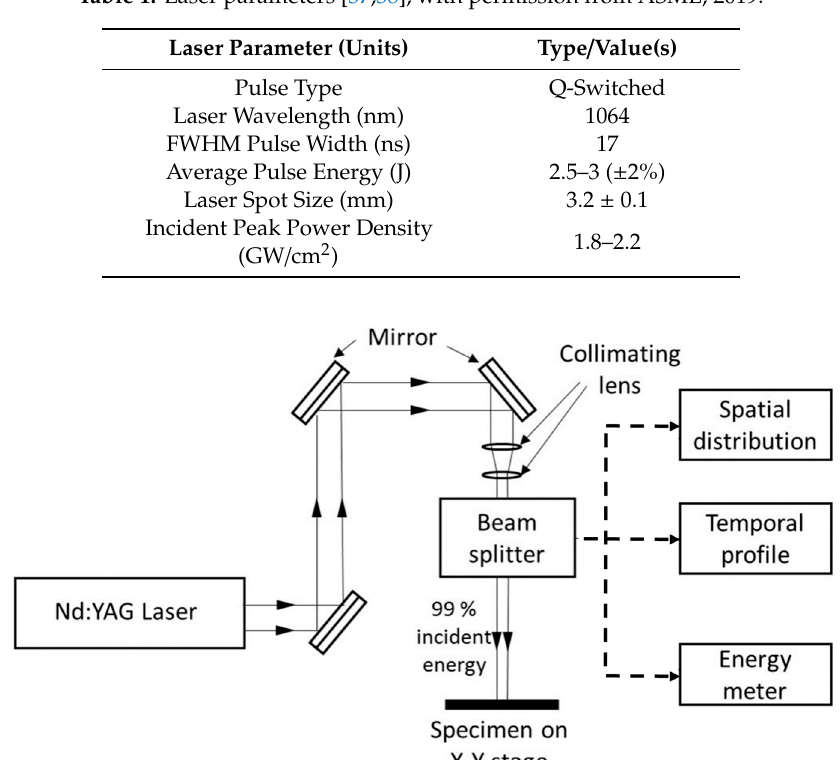
Figure3. LIWandlasercharacterizationsetup. reproducedfrom[37], withpermissionfromASME,2019. Figure 3. LIW and laser characterization setup. reproduced from [37], with permission from ASME, 2019.